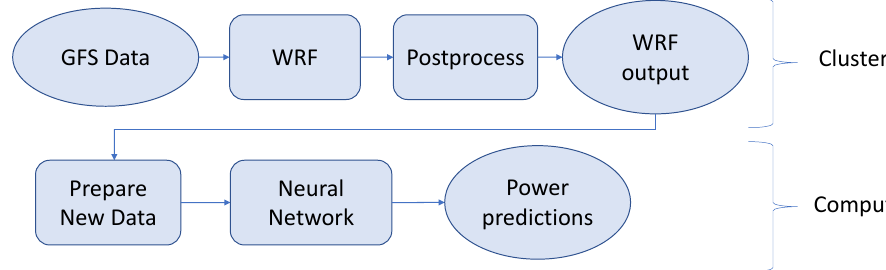
Figure 2. Prediction pipeline.